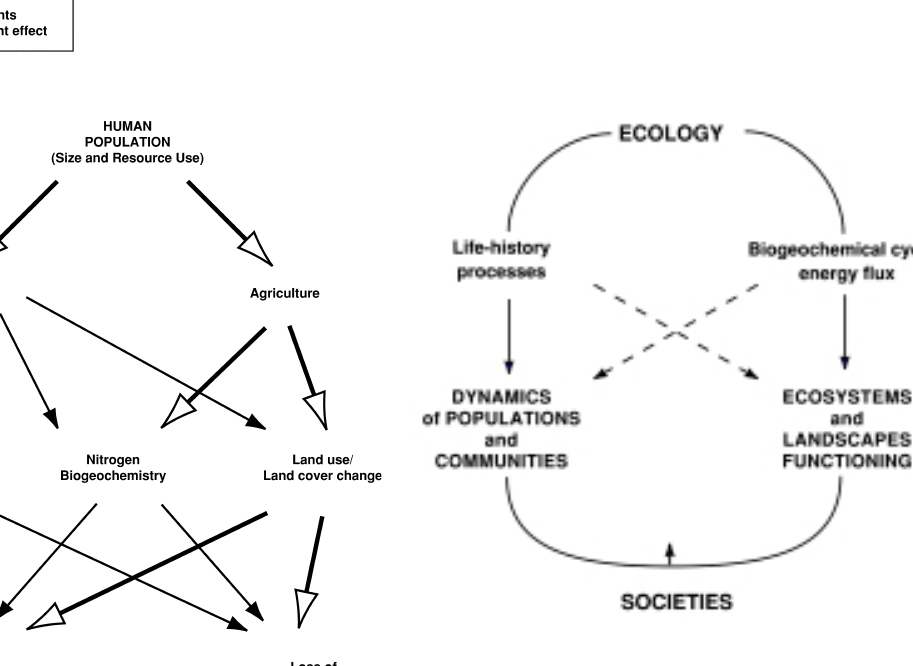
Fig. 2. Ecology, as a natural science, has for goal, on one side the analysis of life-history processes that work within populations and communities’ dynamics, and, on the other side, the study of biogeochemical cycles and energy flows that structure ecosystems and lanscapes. Because human societies depend on and affect these cycles and processes, ecology is called to interact more and more with human